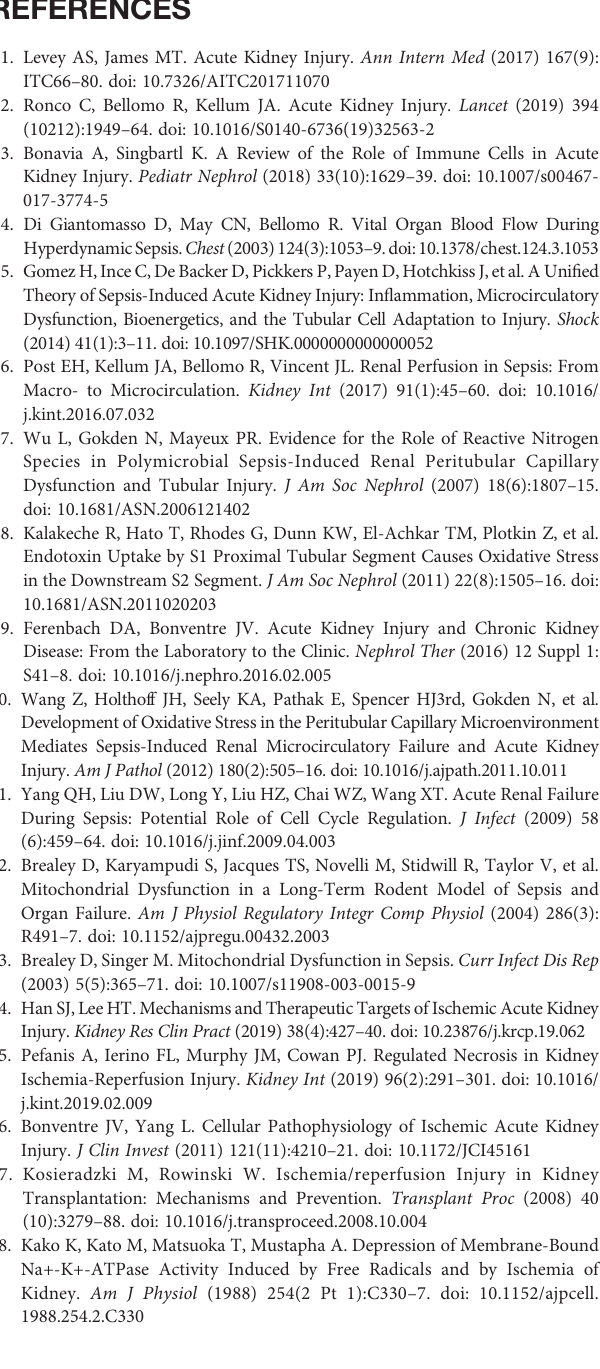
Supplementary Figure 8 | Flow cytometry gating strategy for the determination ofneutrophilcharacteristics.Neutrophilswerederivedfrombonemarrowandblood